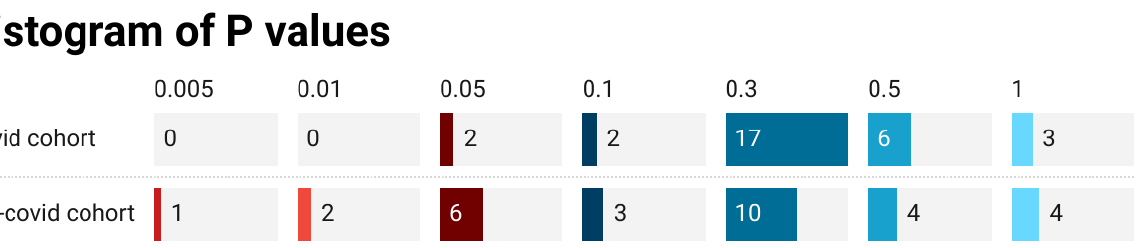
Figure 5. Histograms of Mann–Whitney paired test results comparing for equality of the evolution of the 30 indicators of the COVID and pre-COVID cohorts.